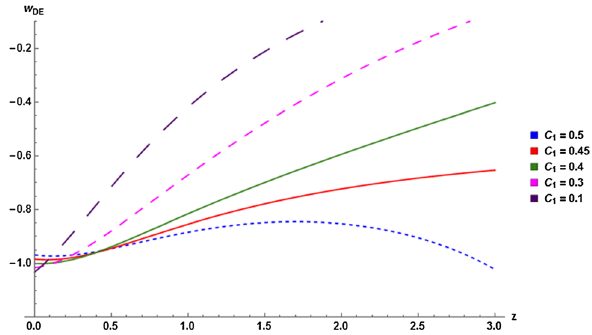
Fig. 2 The redshift-evolution of the equation-of-state parameter w DE of power-law holographic dark energy of Model 1, for fixed γ = 0 . 5 and various values of C 1 in units where k have imposed (cid:7) DE 0 ≈ 0 . 7